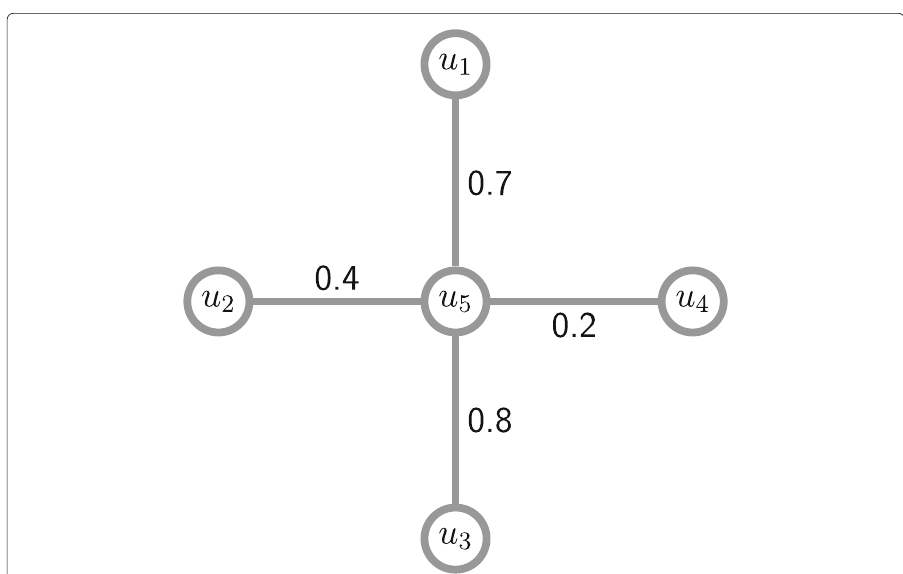
Fig. 1 Ego network of user u 5 . Each node connected to u 5 represents a friend, while the weight on the edge indicates the influence